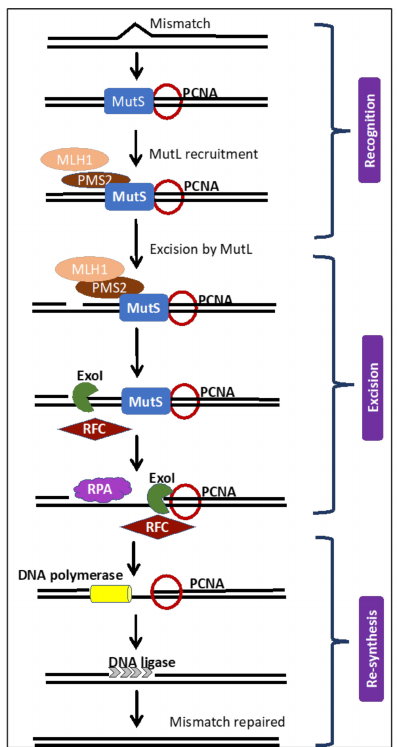
Figure 1. The mismatch repair (MMR) pathway that functions to correct errors in microsatellites. Schematic of the MMR pathway describing the three vital